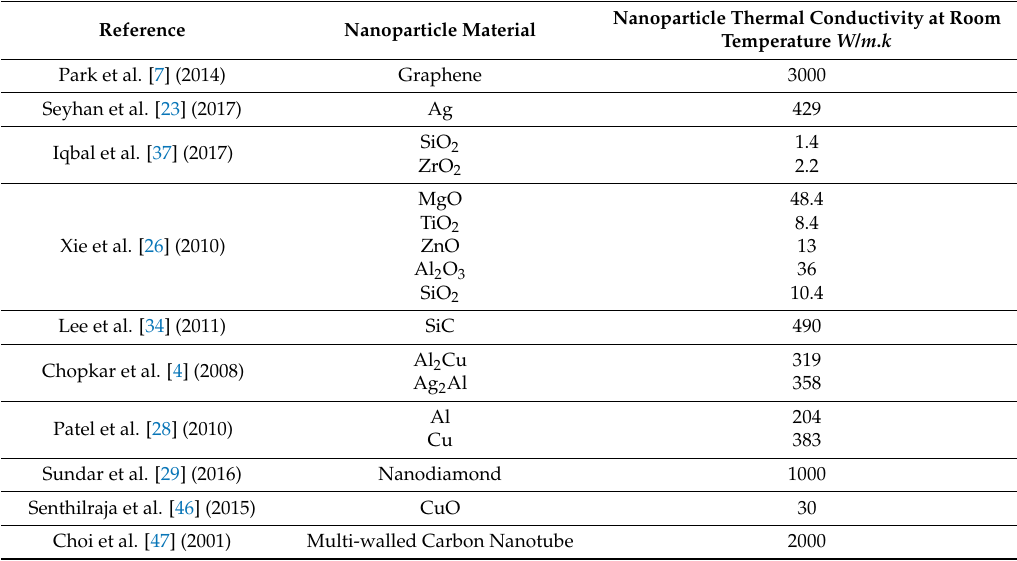
Figure 7. Variation of Ethylene Glycol-based nanofluid thermal conductivity as a function of nanoparticle volume concentration, 𝜑 , for different nanoparticles at room temperature. Table 1. Nanoparticle thermal conductivity.